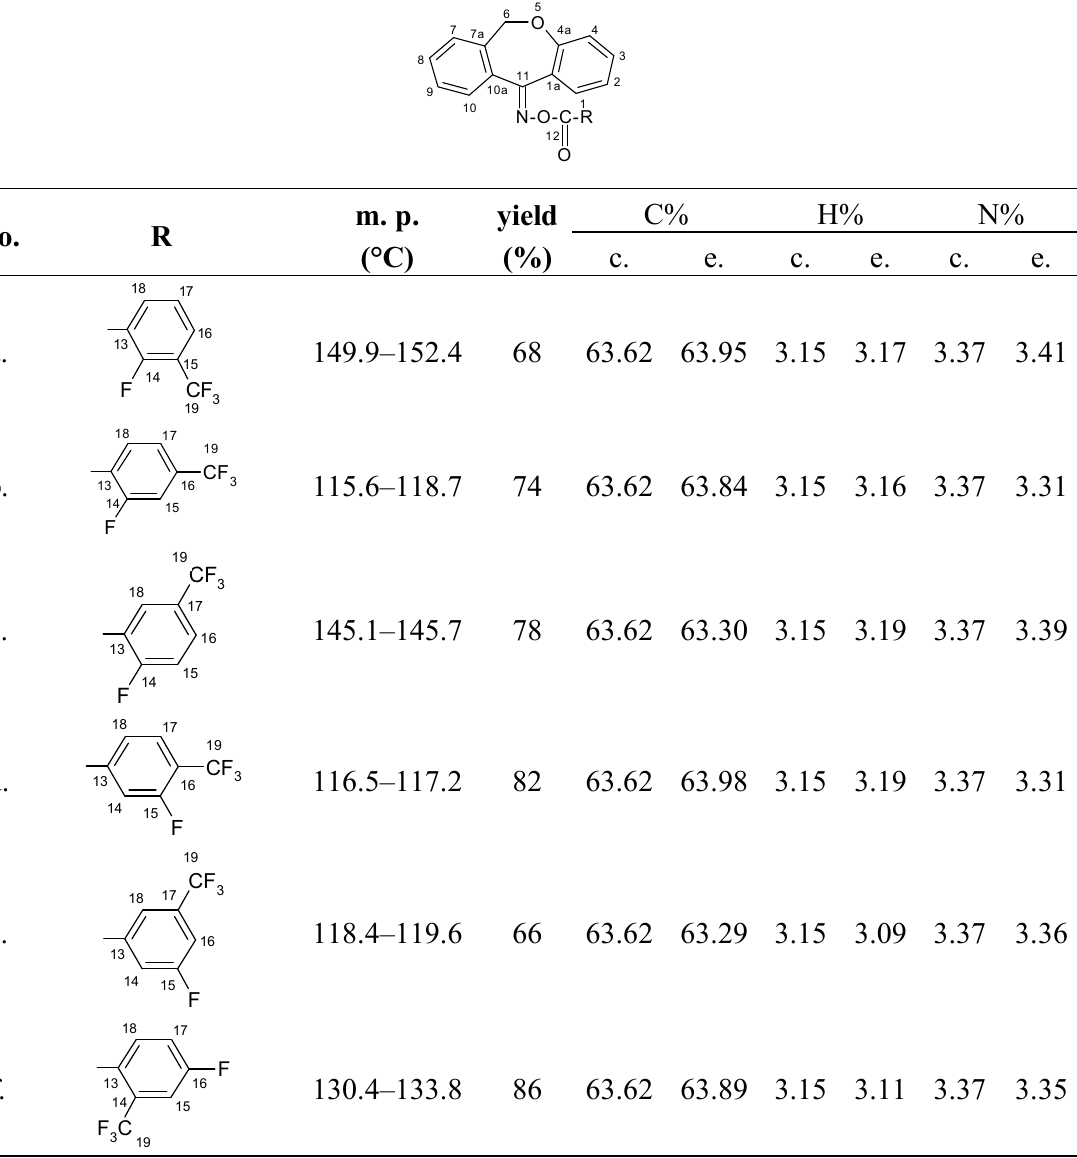
Table 1. Data on the new